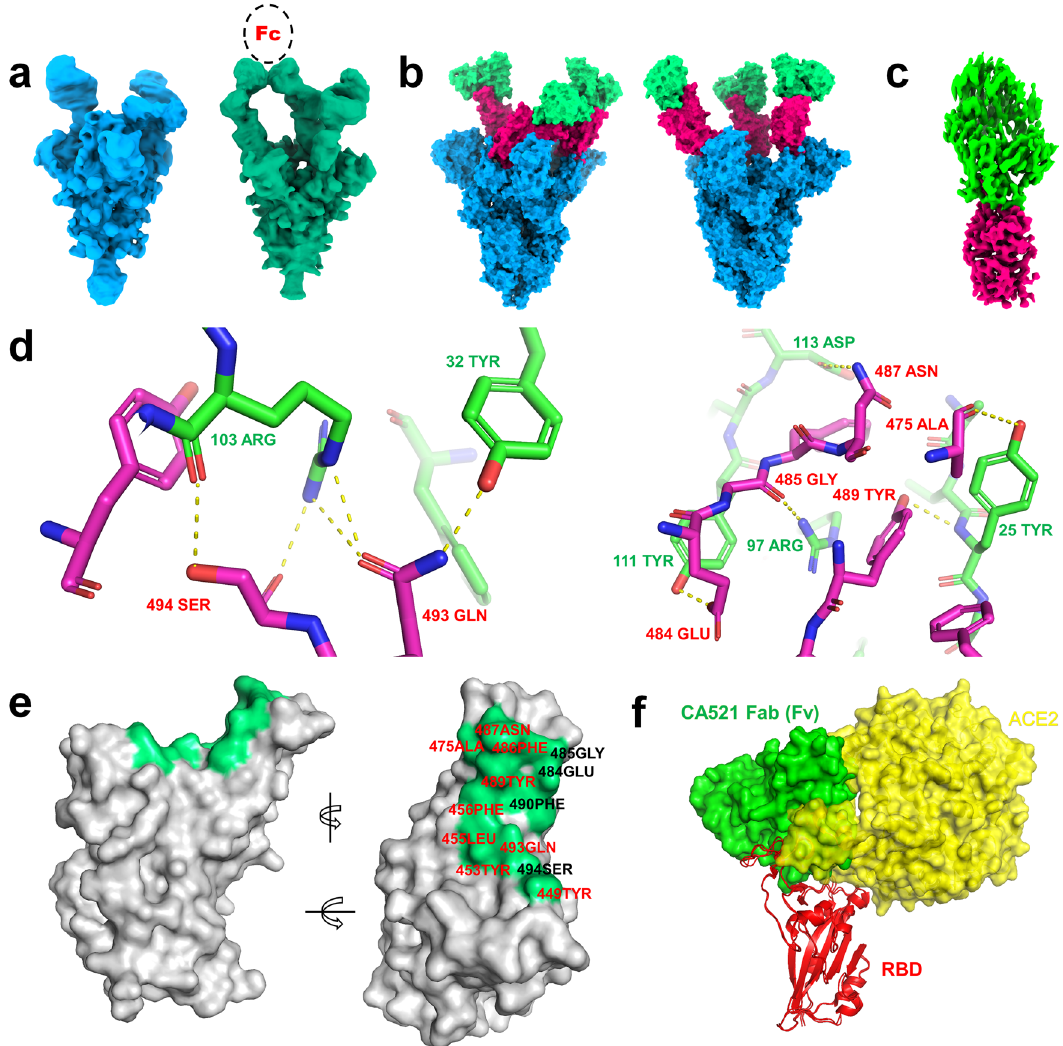
Fig. 5 The cryo-EM structures of CA521 FALA IgG or Fab in complex with Spike protein. a The consensus maps of S-CA521 FALA Fab (Left) and S- CA521 FALA IgG (Right) low-passed to 10 Å to display the densities of three RBDs and antibodies. The black circle with a dashed line represents the Fc fragment of CA521 FALA supposed to connect with two proximal Fabs. All three RBDs are in an open state in the S-CA521 FALA IgG complex, while there is one RBD in the closed state in the S-CA521 FALA Fab complex. b The models of S-CA521 FALA Fab (Left) and S-CA521 FALA IgG (Right) showed as surface. Only Fv (green) of CA521 FALA is well resolved, so other regions are omitted from the models. Magenta: RBD, Blue: another part of Spike protein. c The map of one RBD-Fab sub-complex from S-CA521 FALA Fab complex after focused re fi nement. Magenta: RBD, Green: CA521 FALA Fab. d The polar interactions (dashed yellow lines) between CA521 FALA Fab (green) and RBD (magenta). Residues labeled as red are from RBD, residues labeled as green are from Fab. e The epitopes of CA521 FALA Fab (with a 4 Å cutoff of distance) on RBD (gray surface). The locations of epitopes are displayed as green, and epitopes overlapped with that of ACE2 are highlighted as red labels. f CA521 FALA Fab (green surface) clashes with ACE2 (yellow surface) when binding to RBD (red